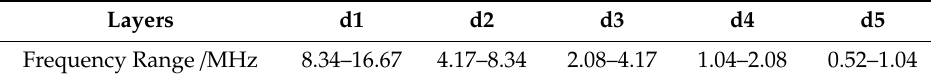
Table 1. The frequency range of decomposed layers.